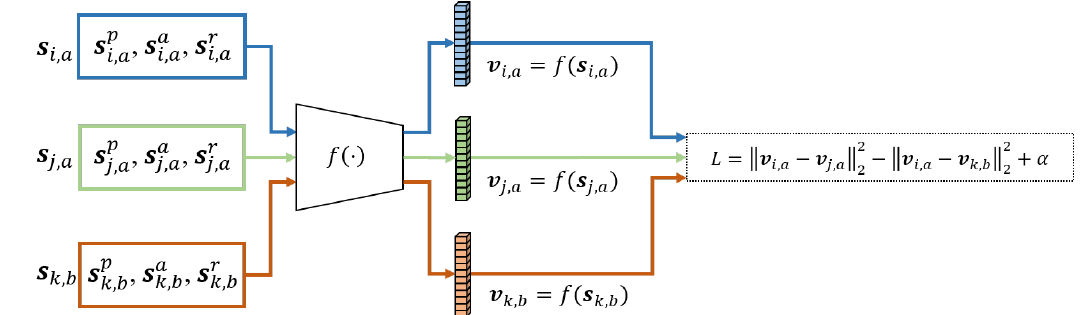
Figure 3. Illustration of the multimodal triplet